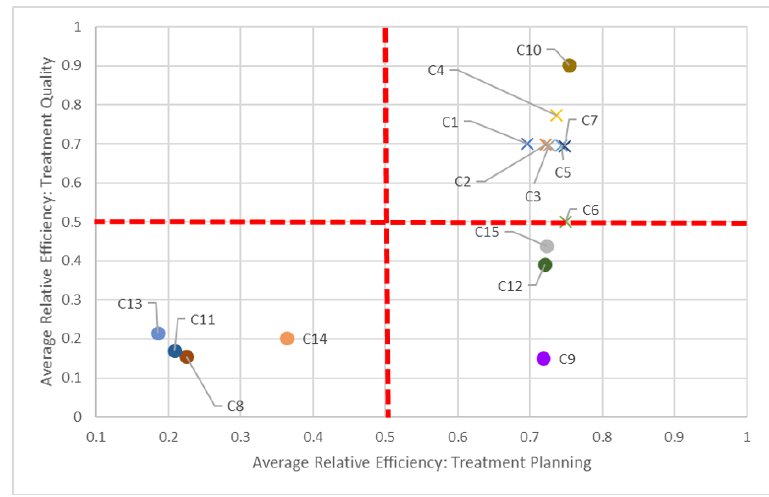
Figure 5. Benchmarking according to planning and quality dimensions (2016).